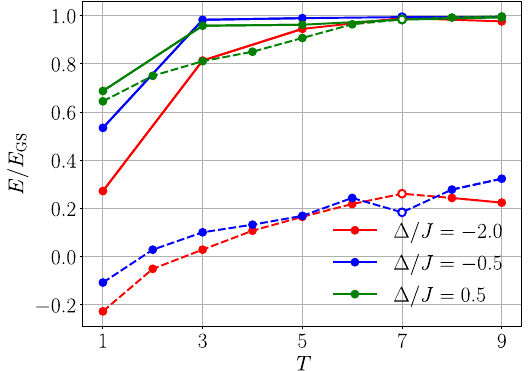
FIG. 3. Heisenberg spin-1 chain: energy minimization against protocol duration T using conventional QAOA (dashed lines) and CD-QAOA (solid lines) for three different states. We start from the AFM state j ψ i i ¼ P j ↑↓↑↓ (cid:4) (cid:4) (cid:4)i and target three different parameter regimes, corresponding to the FM ( Δ =J ¼ − 2 . 0 ), XY ( Δ =J ¼ − 0 . 5 ), and Haldane ( Δ =J ¼ 0 . 5 ) states, respectively. CD-QAOA outperforms conventional QAOA ( p ¼ q= 2 ), more notably in the FM and XY targets where it allows us to reach close to the target state using a short protocol duration. The empty symbols mark the duration at which we show the evolution of the system in Fig. 20. The alternating unitaries for conventional H ; H QAOA are generated by A 1 2 g [cf. Eq. (4)]; for QAOA ¼ f CD-QAOA, we extend this set using adiabatic gauge potential H ; H ; Z; X j X ; Y; XY; YZ; X j Y − XY; terms to A 1 2 CD − QAOA ¼ f Y j Z − YZ g . The circuit depths are q ¼ 28 ( Δ =J ¼ − 2 . 0 ), q ¼ 18 ( Δ =J ¼ − 0 . 5 ), and q ¼ 18 ( Δ =J ¼ 0 . 5 ). The cardinality of the CD-QAOA sequence space is j A jðj A j − 1 Þ q − 1 ≈ 10 16 at q ¼ 18 . The system size is N ¼ 8 , where dim ð H Þ ¼ 498